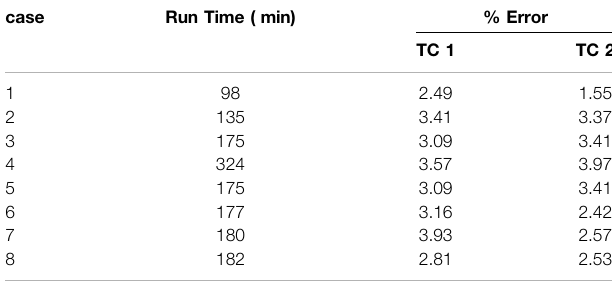
TABLE 6 | Cases examined for Thermal Model Validation (Double Ellipsoid).